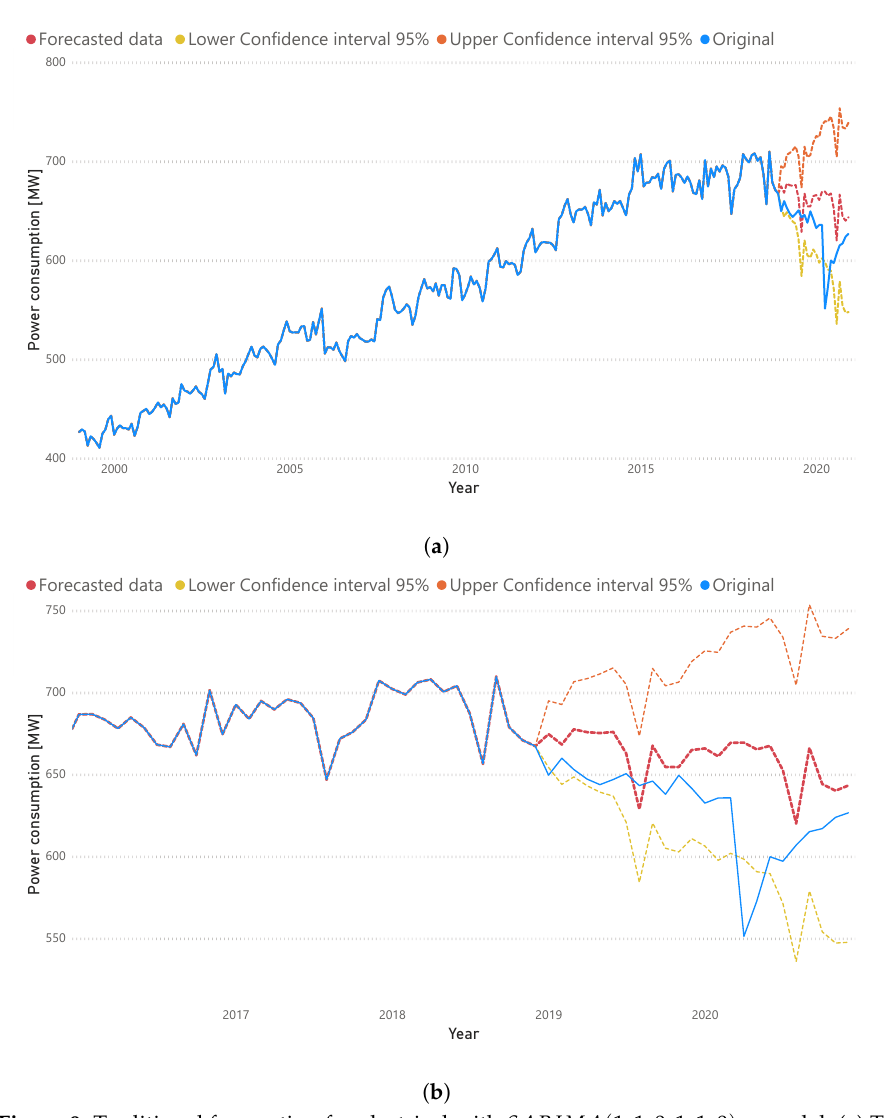
Figure 9. Traditional forecasting for electrical with SARIMA ( 1,1,0,1,1,0 ) 12 model. ( a ) Traditional forecasting for years 2019–2020. ( b ) Forecasting for years 2019–2020 (zoomed since